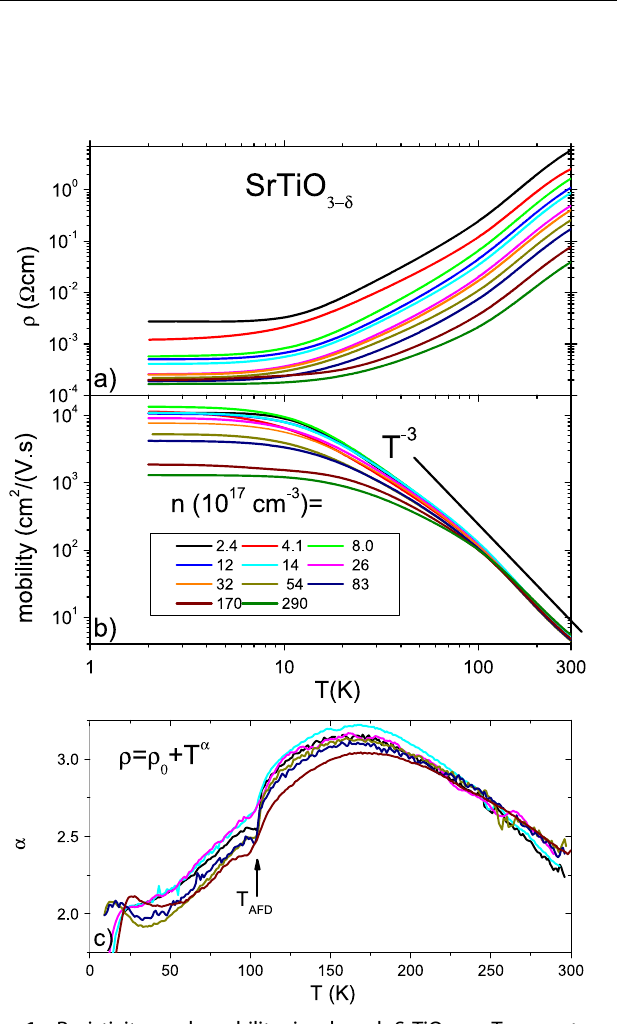
Fig. 1 Resistivity and mobility in doped SrTiO 3 . a Temperature dependence of resistivity in SrTiO 3 − δ as the carrier concentrations is tuned from 10 17 to 10 19 cm − 3 . Room-temperature resistivity is several hundred times higher than low-temperature resistivity. b